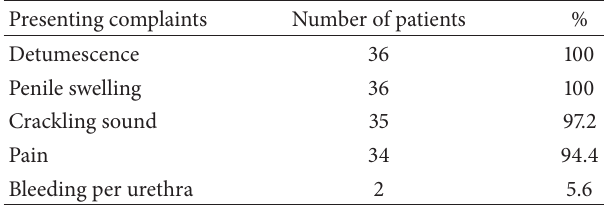
Table 2: Presenting complaints.